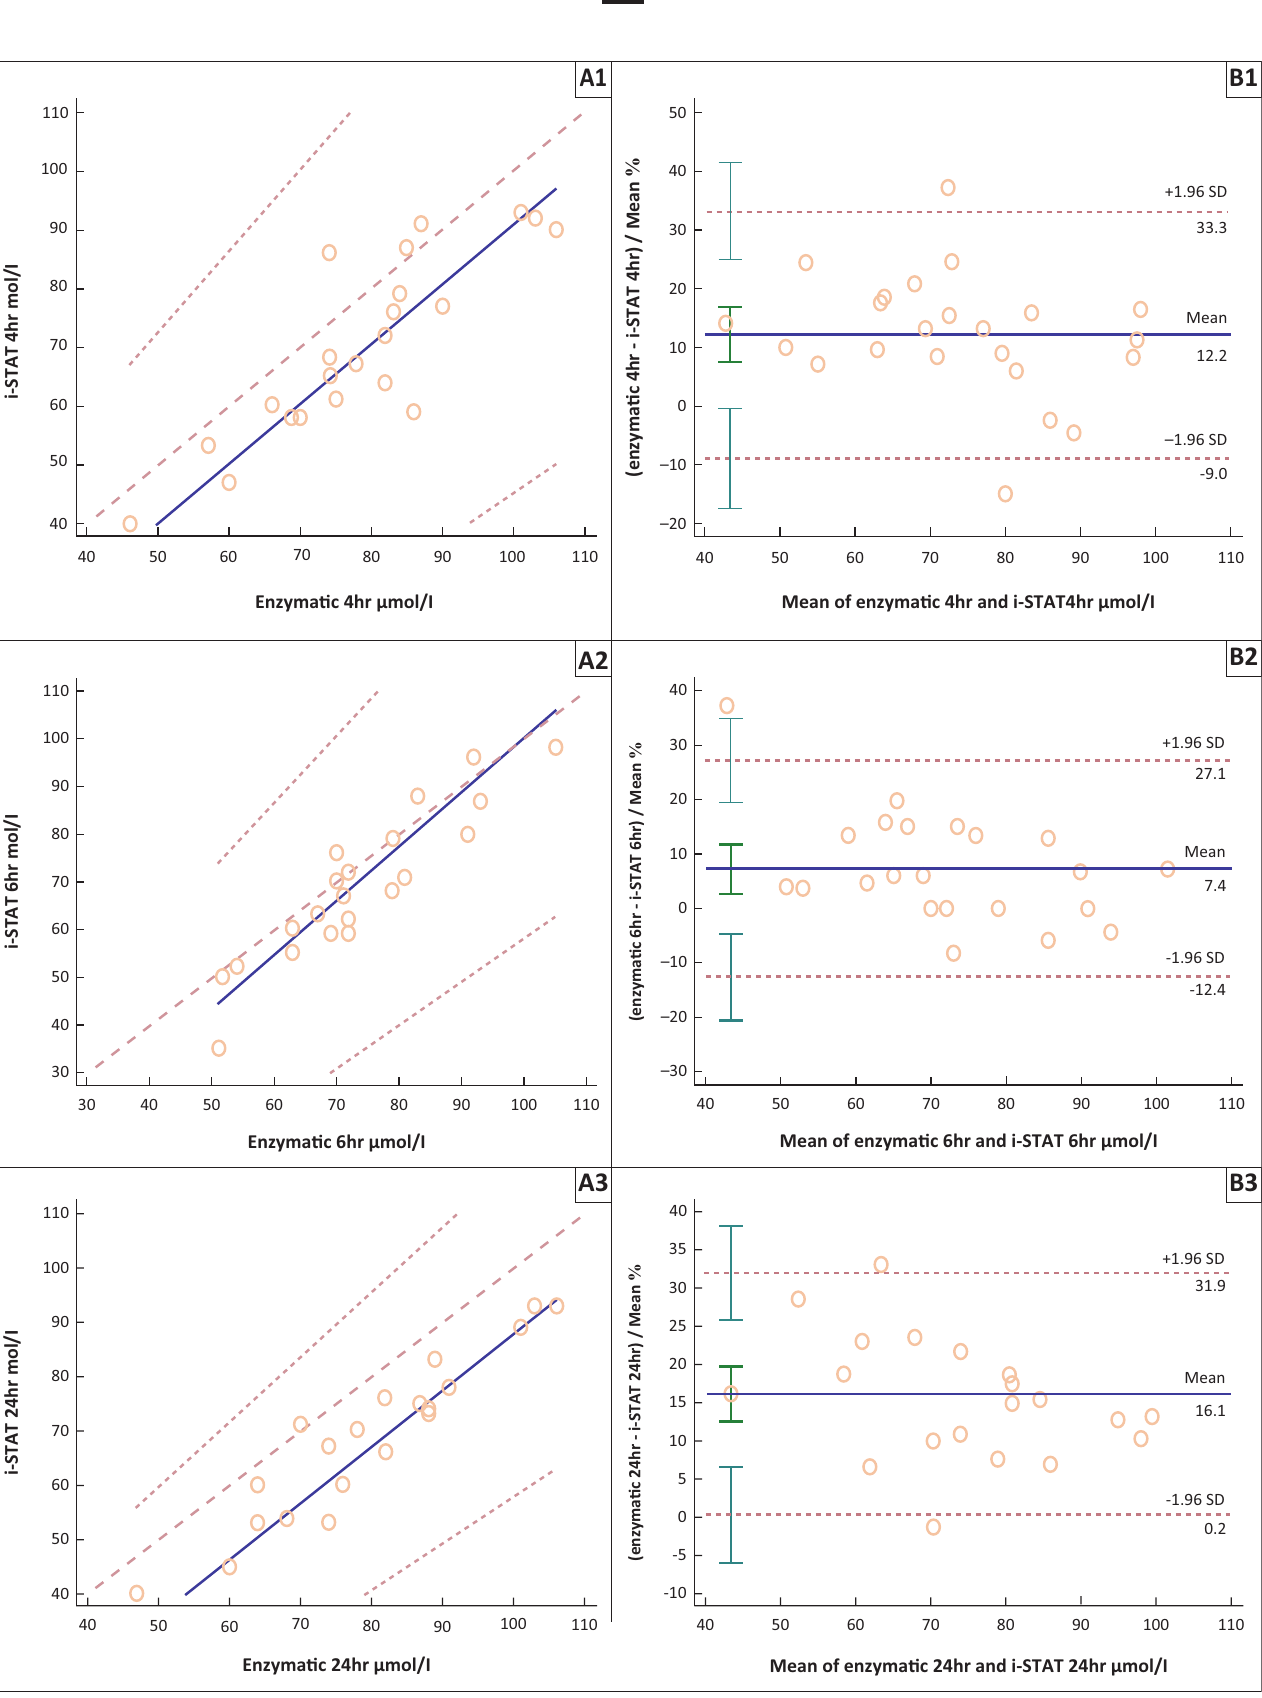
FIGURE 4: Passing-Bablok regression curves (A) and Bland-Altman plots (B) comparing creatinine concentrations from the i-STAT device with those obtained from the enzymatic method. Creatinine concentrations at (1) < 4 h, (2) 6 h, (3) 24 h, (4) 48 h, (5) 72 h and (6) 96 h.